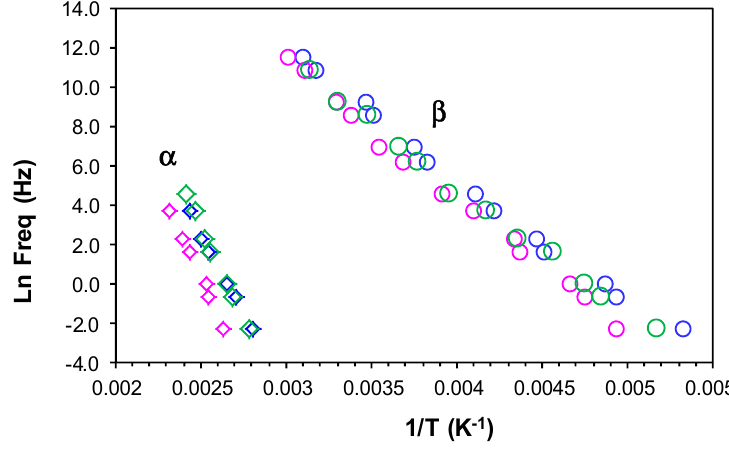
Figure 13. Relaxation map for the fully cured ELP800 (blue), ELP25000 (pink), and ELP2000 (green) systems obtained by DRS at 2 °C/min.